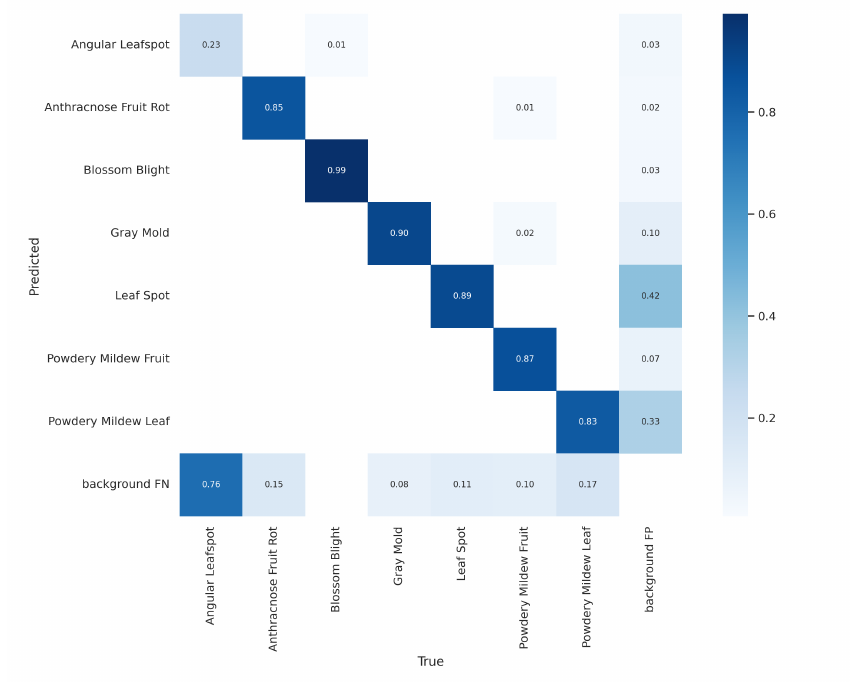
Figure 21. Confusion matrix obtained on the test